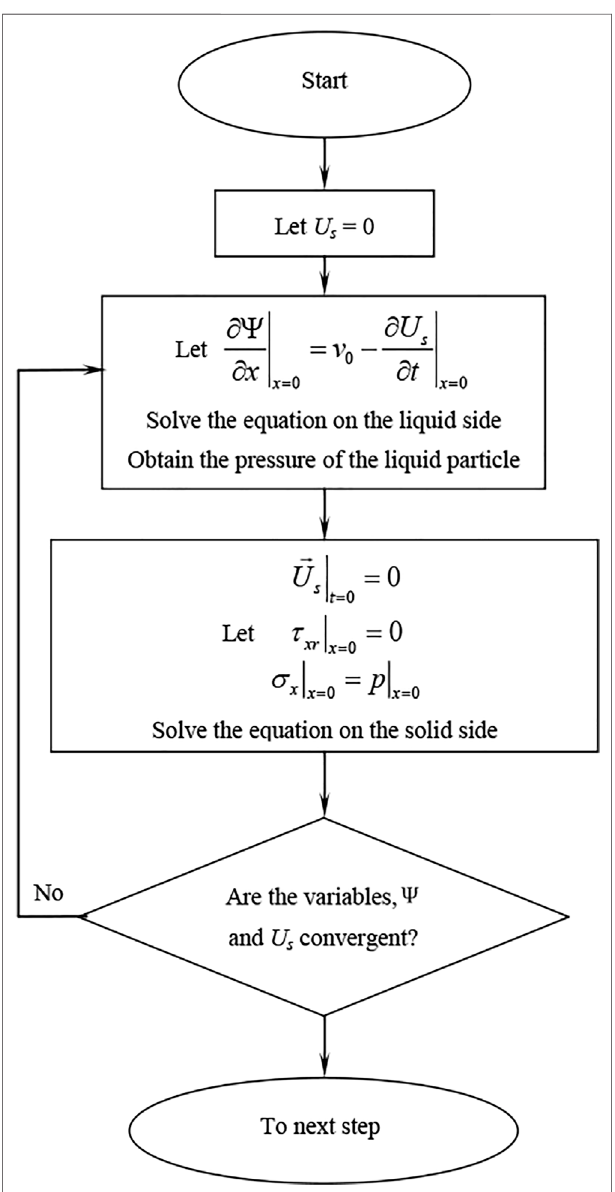
FIGURE 3 | The fl ow diagram of the liquid-solid impact calculation.